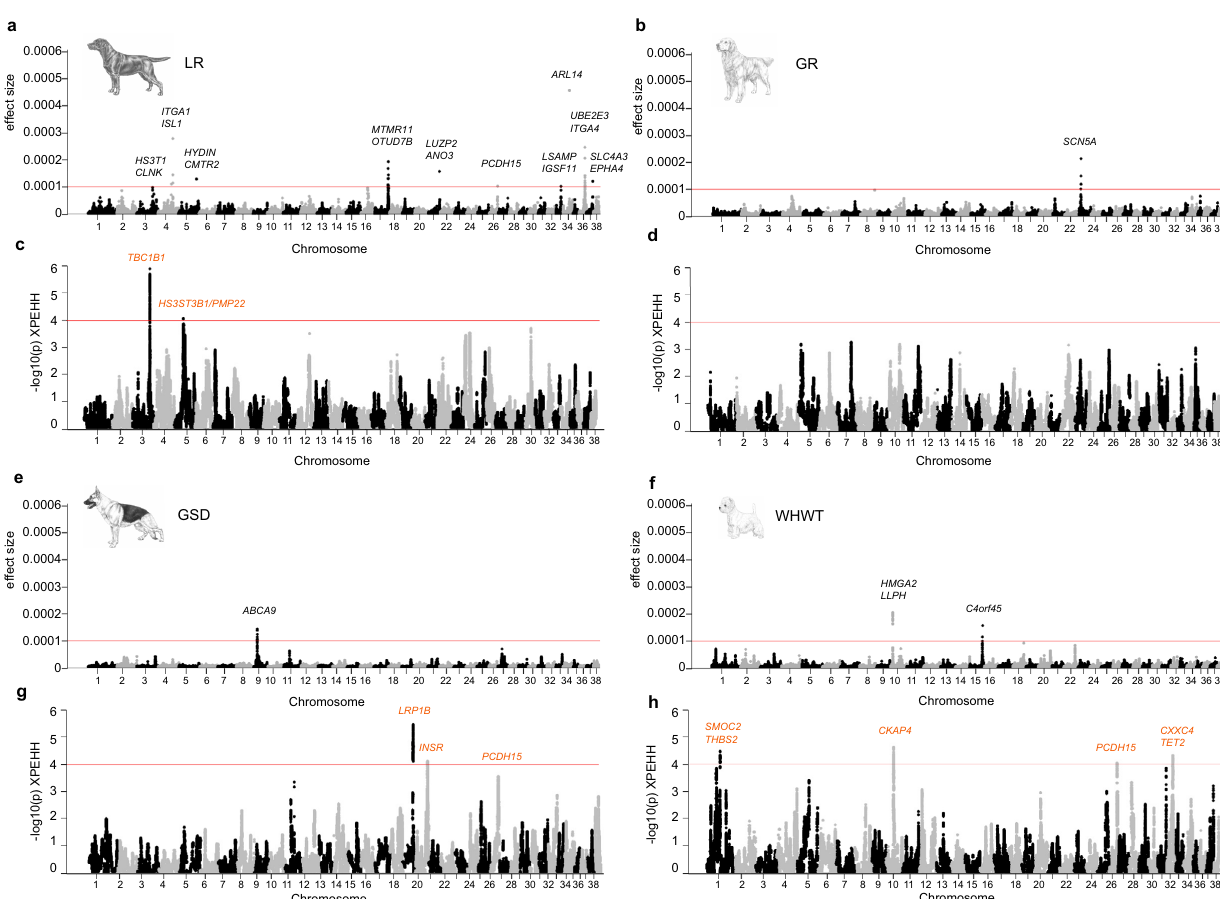
Fig. 1 BayesR and XP-EHH regions associated with canine AD in four dog breeds. The results from BayesR analyses are presented for LR ( a ), GR ( b ), GSD ( e ), and WHWT ( f ). The red line de fi nes the cutoff for AD effect variants at absolute effect size of 0.0001 resulting in 11 AD-associated loci in LR, one locus in GR, one in GSD, and two in WHWT above this threshold. The closest protein-coding gene(s) to the top effect variants are speci fi ed for each locus. Panels c , d and g , h present genome-wide scans for signatures of selection in canine AD cases or controls for each breed and candidate regions under selection are de fi ned by selection variants above the threshold line (orange; -log 10 (p) XP-EHH = 4). Protein coding gene(s) closest to the top selection variants for each candidate region of selection are highlighted in